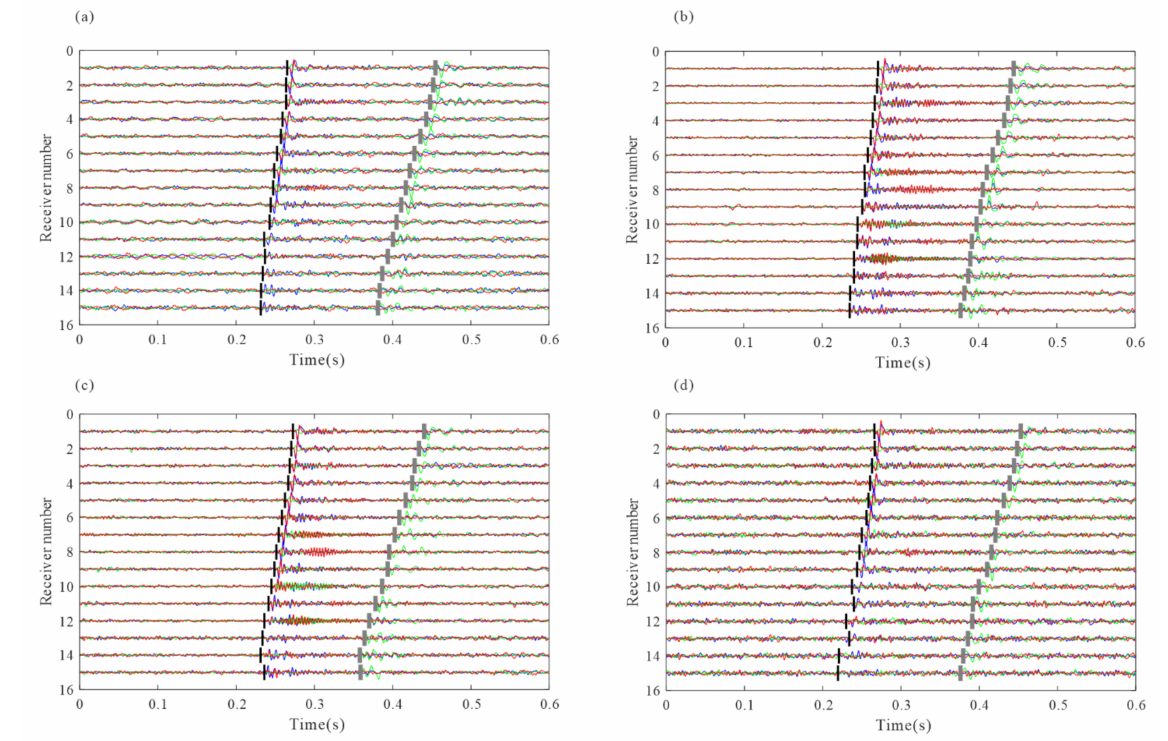
Figure 10. Four microseismic events and their P- and S-wave arrival picks. The balck vertical bars denote the P-wave arrival picks, and the gray ones denote those of the S-wave. Blue, green, and red lines represent rotated x-, y-, and z-components, respectively. ( a ) Event No.1; ( b ) Event No.2; ( c ) Event No.3; ( d ) Event No.4.